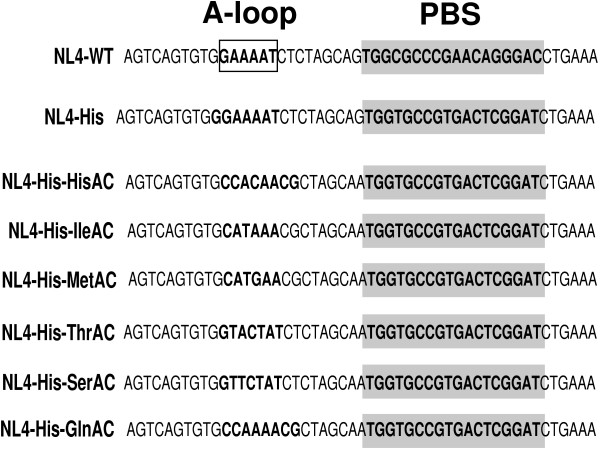
HIV-1 proviral genomes with mutated A-loop and PBS. The A-loop (boxed) and PBS (shaded) were altered in the NL4 proviral clone to be complementary to tRNAHis, tRNAIle, tRNAMet, tRNAThr, tRNASer or tRNAGln. The NL4-WT contains a PBS and A-loop complementary to the 3' terminal 18 nucleotides and the anticodon of tRNALys,3. The NL4-His contains a PBS complementary to tRNAHis but the A-loop is complementary to the anticodon region of tRNALys,3. The remaining proviral clones contain a PBS complementary to tRNAHis with additional mutations in the A-loop to be complementary to the anticodon of the designated tRNA (e.g. NL4-His-HisAC).